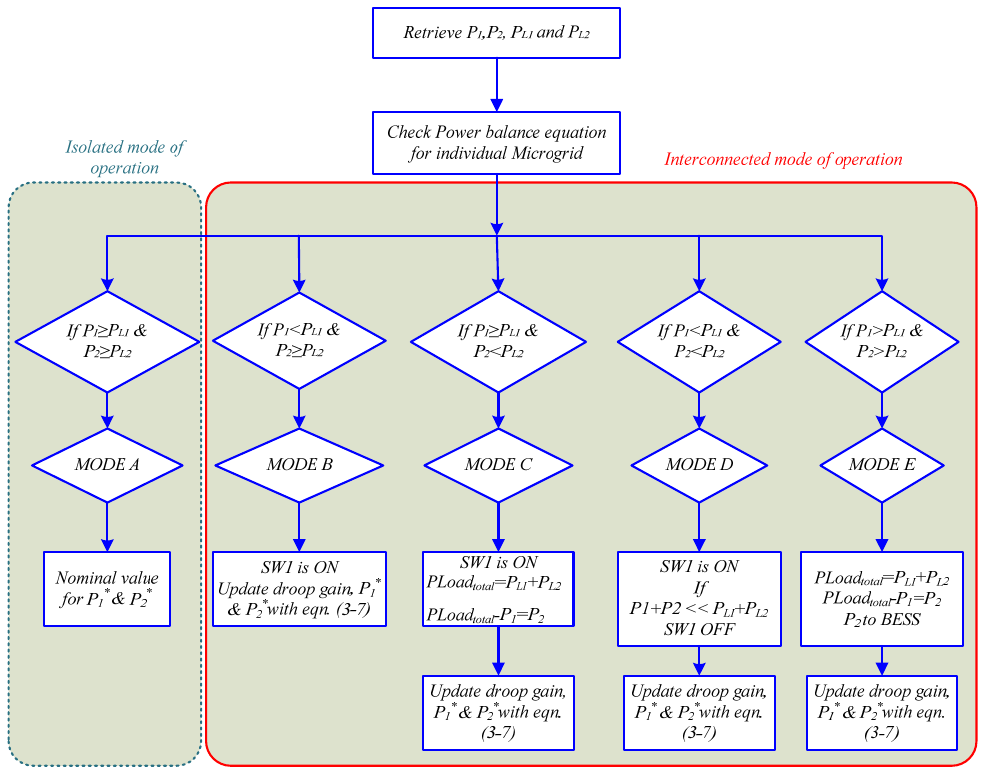
Figure 4. Flow chart for power setpoint calculation with all possible power flow scenarios.